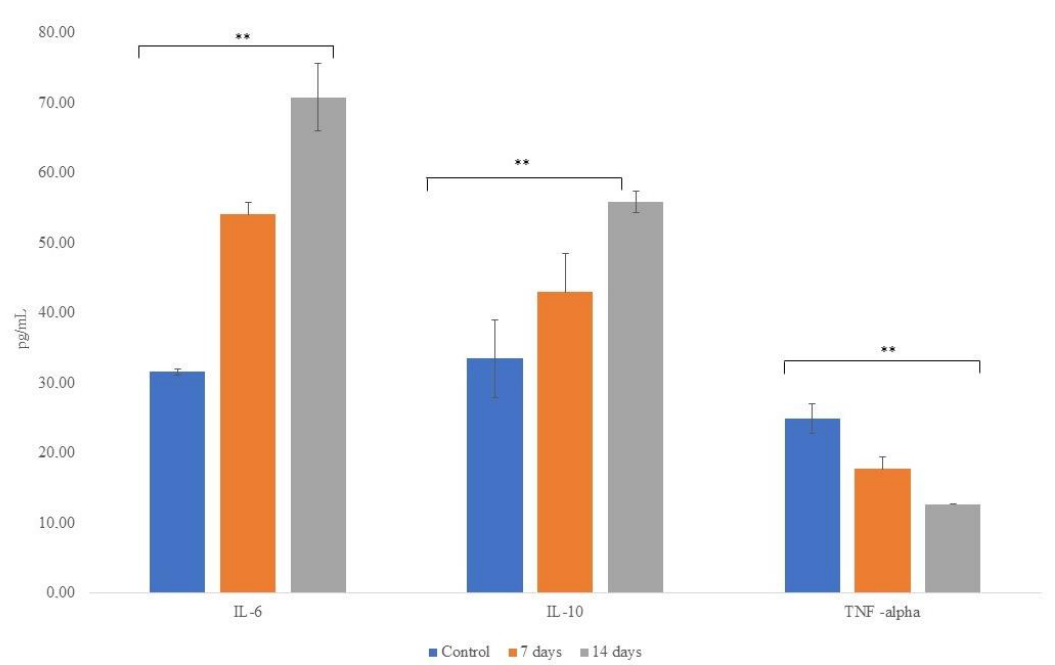
Figure 8. Concentrations of anti-inflammatory cytokines IL-6 and IL-10 and pro-inflammatory cytokine TNF- α following exposure of the cells to colonic media after dosing with L. helveticus R0052 and B. longum R0175 for 7 and 14 days. Asterisks (**) represent significant differences relative to control according to the paired t -test (** p < 0.01).